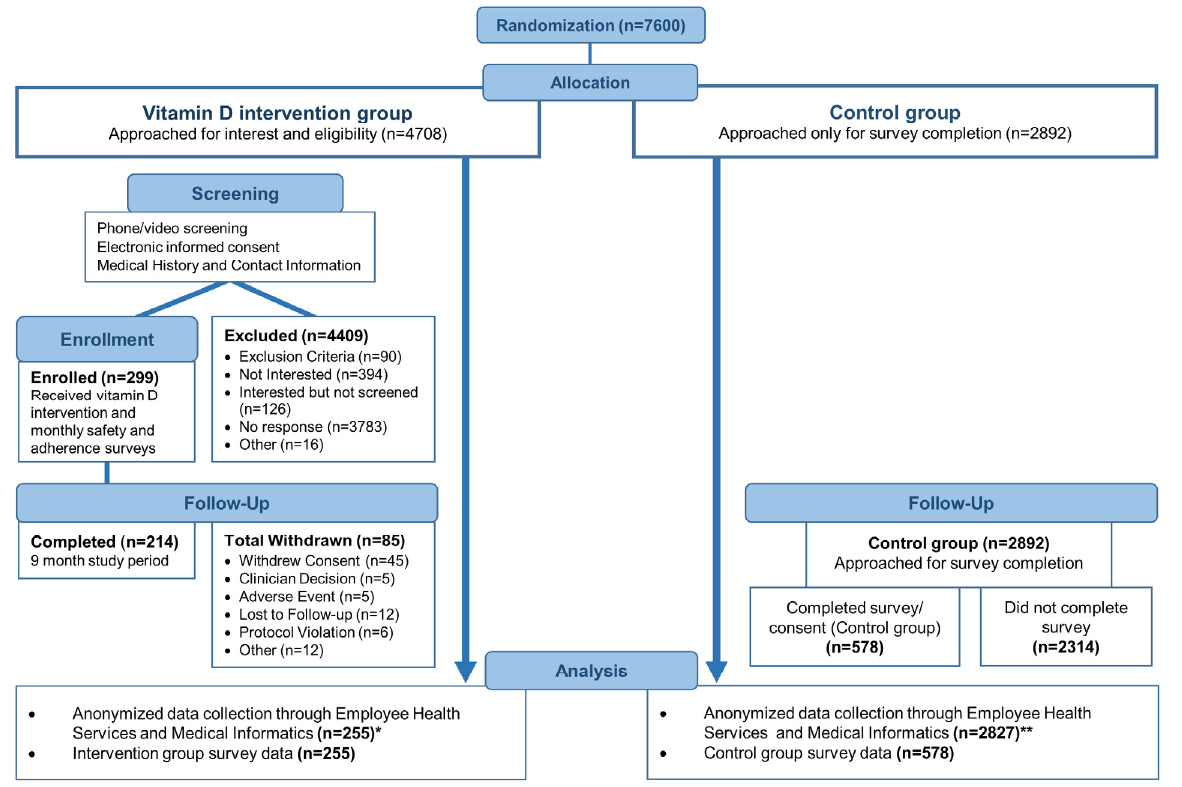
Figure 1. CONSORT trial flowchart. * Out of 299 intervention subjects, 44 subjects were excluded from analysis because they were not on 5000 IU vitamin D3 per day for at least 60 days, a time- frame that is considered to be protective [25]. The resulting 255 subjects included subjects who completed the 9-month study period and early withdrawals. ** Employee Health was unable to locate 27 control subject records for unknown reasons. A possibility for missing records could be due to name changes over the course of the study. Another 38 control subjects were found to have been terminated from employment prior to the study observation period and were excluded from analyses ( n = 2892 − 27 − 38 =